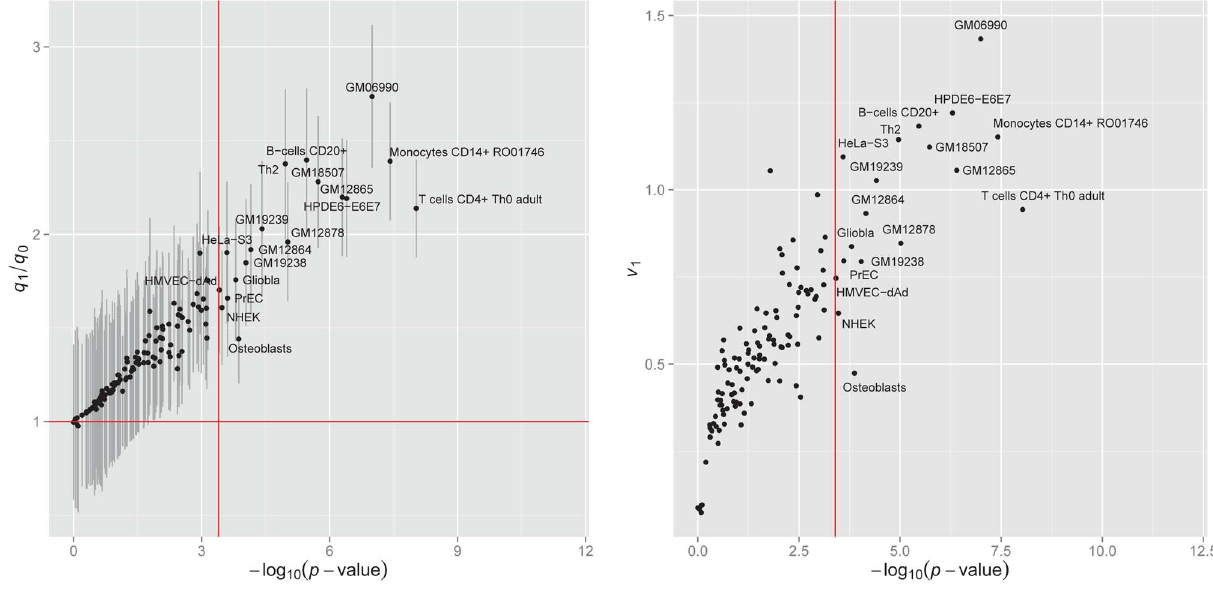
Figure 8. Enrichment of the DNase I hypersenstivity site annotation data from 125 cell lines for bladder cancer. Left panel: { log( p { value ) of hypothesis testing (13) vs. fold enrichment ^ qq 1 = ^ qq 0 . The vertical red line corresponds to the significance level ( a =0.05) after Bonferroni correction. The horizontal red line corresponds to ratio=1. Right panel: The normalized variance component u 1 (2) given by LMM v.s. { log( p { value ) given by GPA.